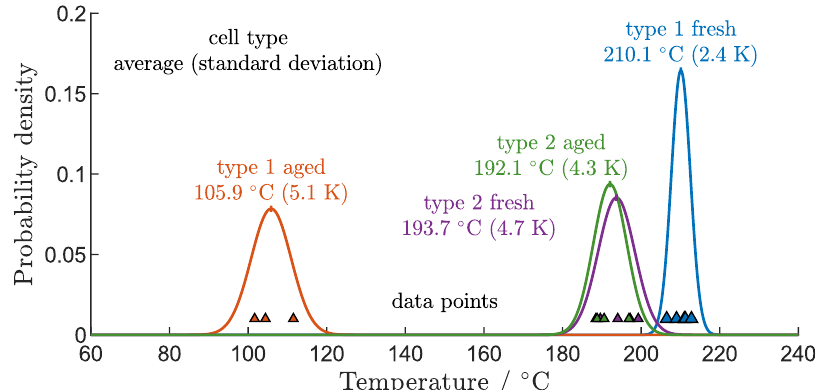
Figure 8. Measurement points (triangles) of all measured TR onset temperatures and assumed normal distribution (lines) with standard deviation and mean values for all performed thermal stability tests and filtered by aged and fresh cells of both